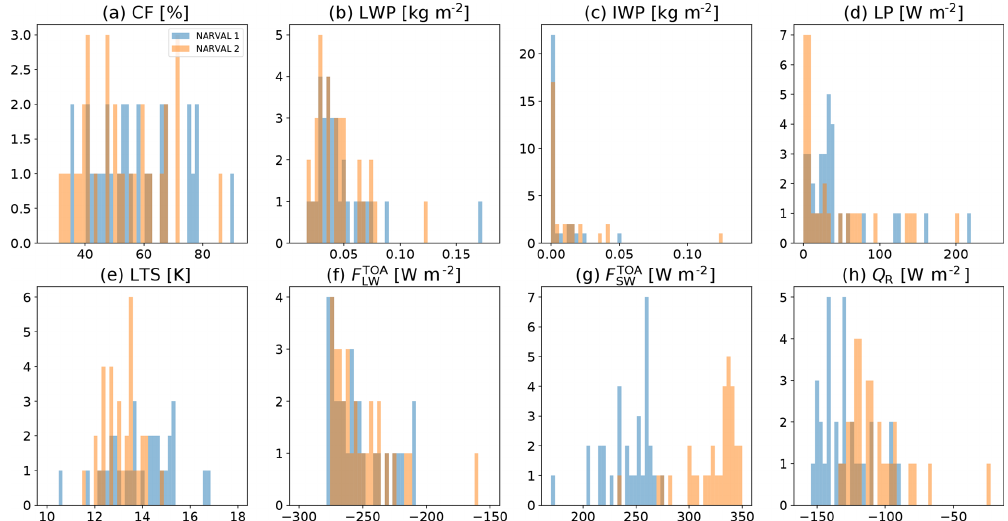
Figure 2. Histograms of mean (time and space) cloud and atmospheric properties for the base simulations with CDNC = 20cm − 3 (clean simulations) for each day of the 2 months that were simulated. Blue represents the NARVAL 1 month (December 2013), while orange the NARVAL 2 month (August 2016). (a) Cloud fraction – CF, (b) liquid water path – LWP, (c) ice water path – IWP, (d) precipitation latent heat flux – LP, (e) lower-tropospheric stability – LTS, (f) top-of-atmosphere longwave flux – F TOA , (g) top-of-atmosphere shortwave flux – LW F TOA , and (h) atmospheric column radiative term – Q R . SW Table 1. The monthly-mean value of each of the properties presented in Fig. 2 ± 1 standard deviation for each month and the p value of the two-sample independent t test. The p values which demonstrate a significant difference between the months ( < 0 . 05) are presented in bold. Mean NARVAL 1 Mean NARVAL 2 p -value t test 57 . 2 ± 13 .